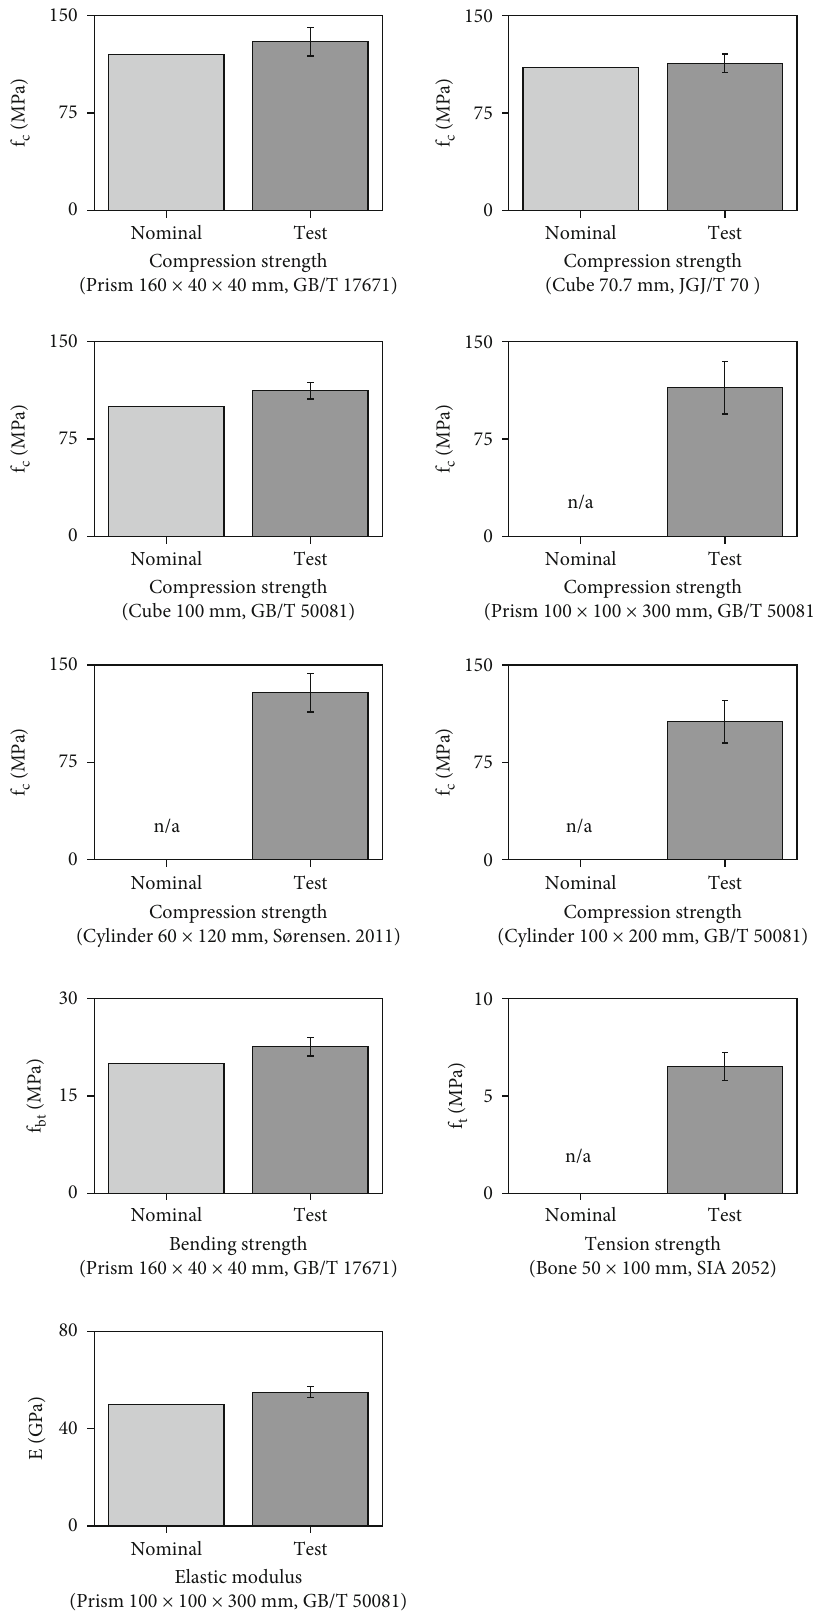
Figure 2: Strength and sti ff ness properties with a 95% con fi dence interval for the grout